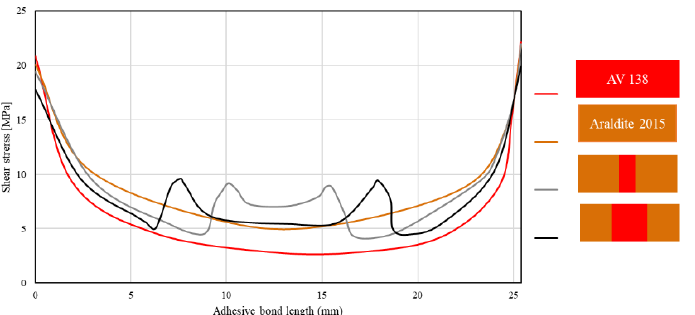
Figure 11. Effect of length ratio on shear stress distribution in mixed adhesive joint. Adapted from [109].